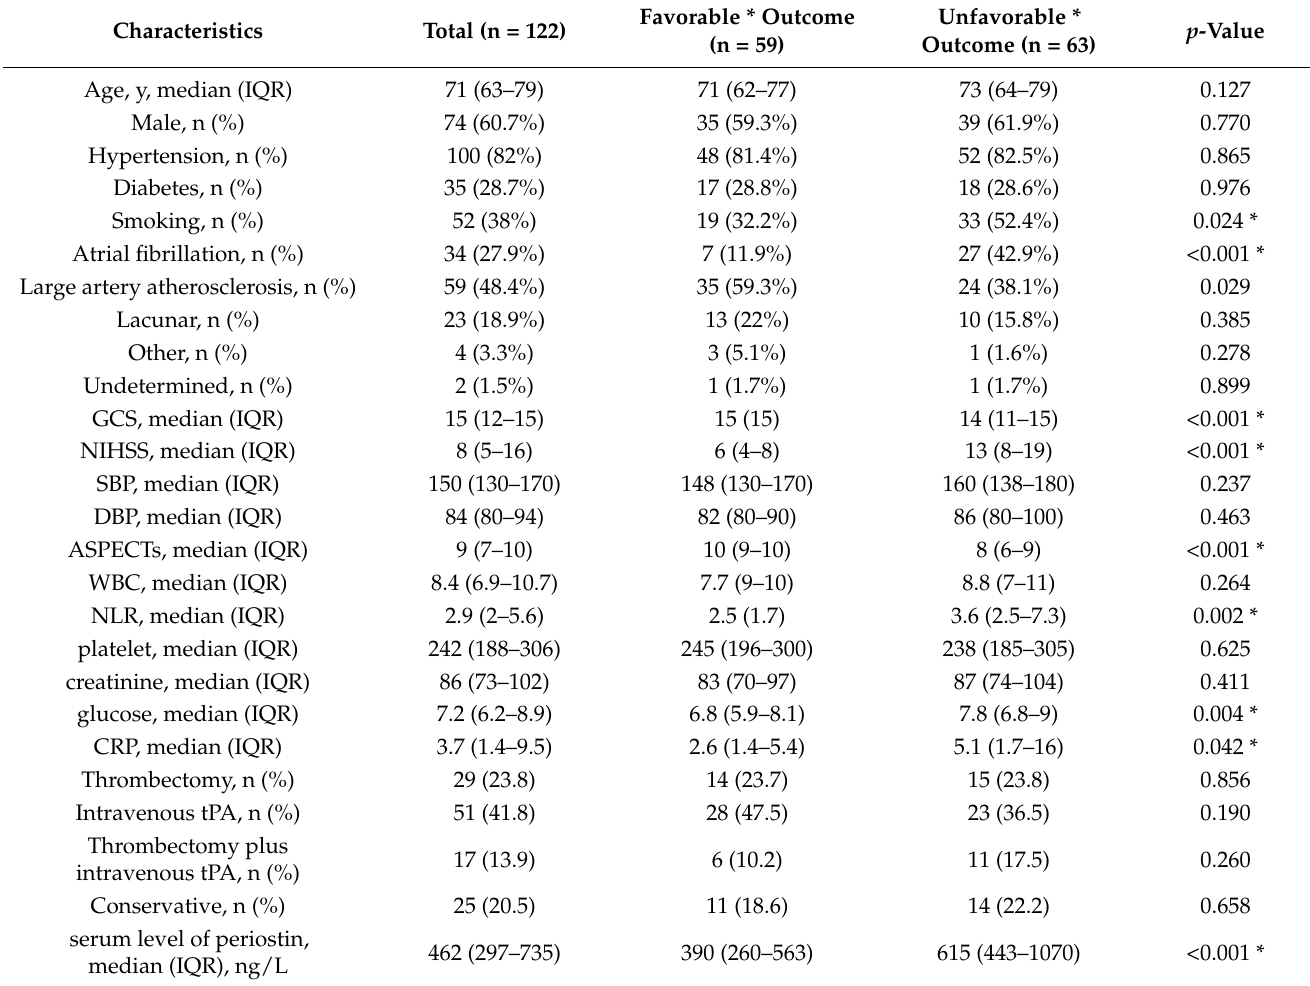
Table 1. Baseline characteristics of the study population. Continous variables are expressed as medi- ans (interquartile ranges). Categorical values are given as frequencies (percentages). Abbreviations: GCS, Glasgow coma scale; NIHSS, National Institutes of Health Stroke Scale; SBP, systolic blood pressure; DBP, diastolic blood pressure; ASPECTs, Alberta stroke programme early CT score; WBC, white blood cell; NLR, neutrophil–lymphocyte ratio; CRP, C-reactive protein; tPA, tissue plasminogen activator; * at 90-day